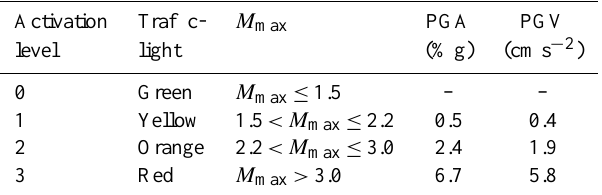
Table 1. Threshold values of seismic parameters measured in the internal control volume utilized to establish the levels of activation: Maximum Magnitude ( M max ), Peak Ground Acceleration (PGA), Peak Ground Velocity (PGV). For any transition from one level to the other is sufficient that one of these parameters exceed the indi- cated